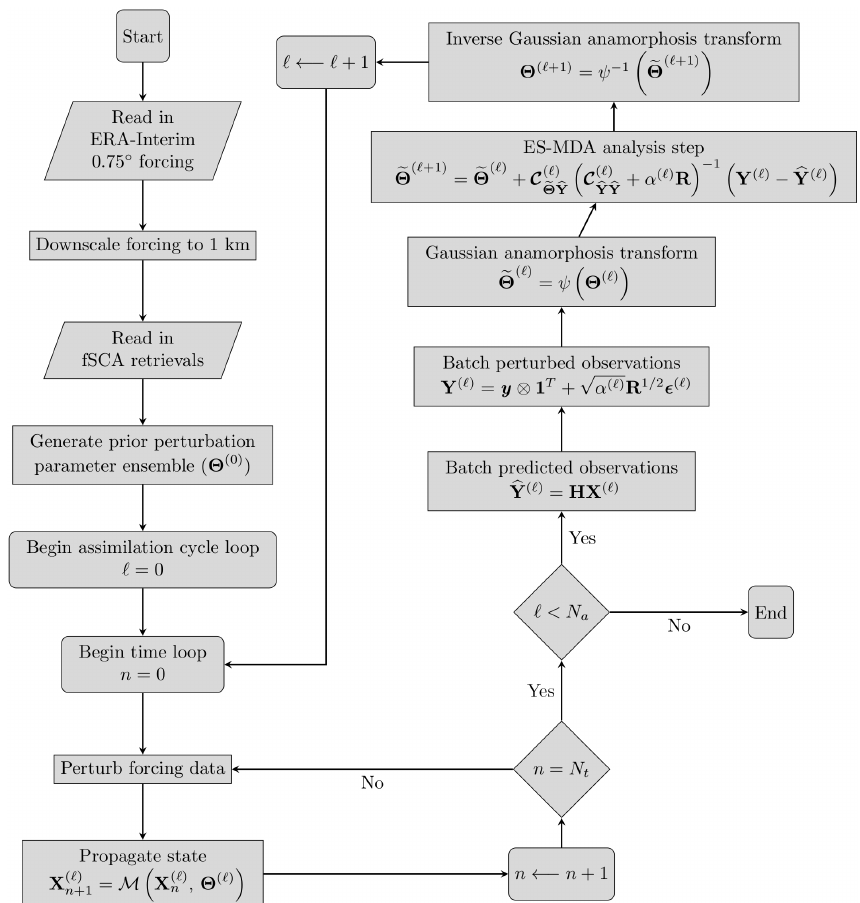
Figure 3. Flowchart depicting the methodology with the ES-MDA as the DA scheme. Symbols are defined in the